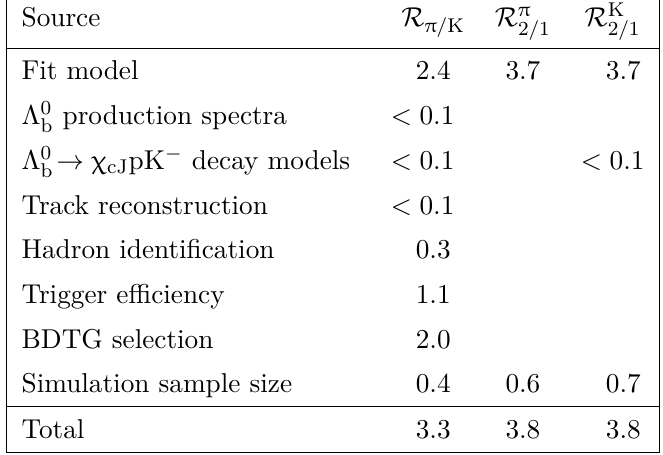
Table 2 . Relative systematic uncertainties (in %) in the ratios of branching fractions. The total uncertainty is obtained as the sum of individual components in quadrature. Empty cells correspond to cases where no uncertainty is